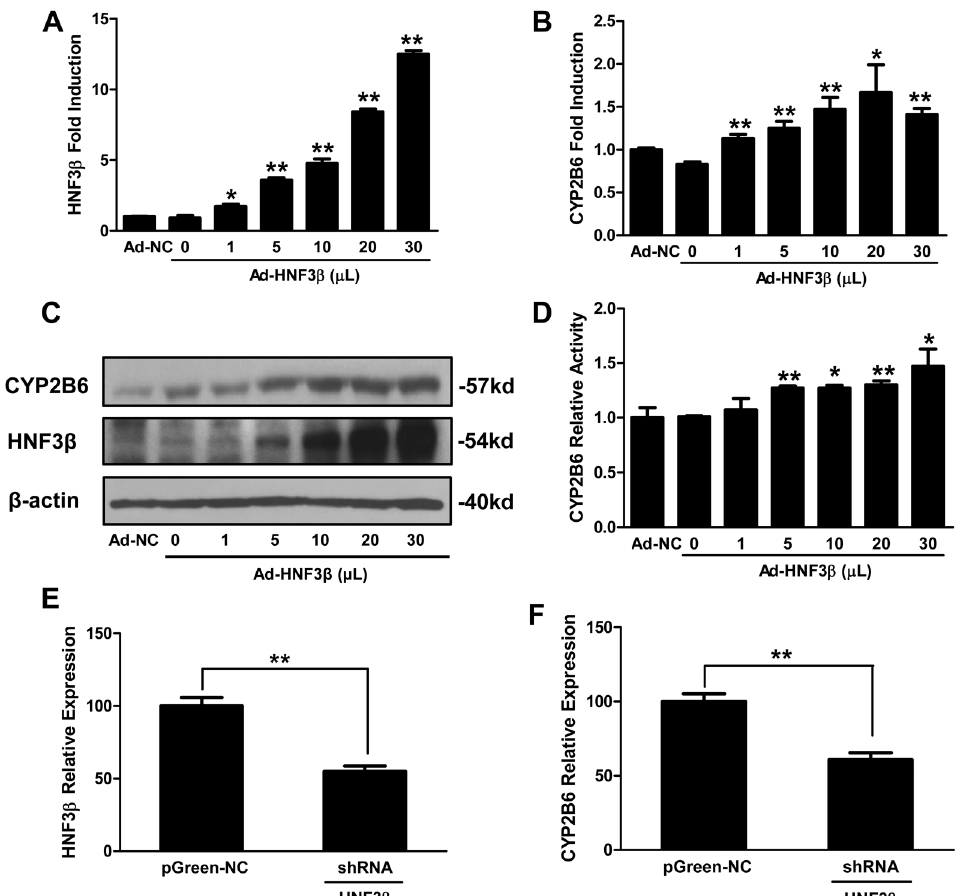
Fig 2. Effects of HNF3 β on the expression and activity of CYP2B6 in HepG2 cells. HepG2 cells were infected with Negative Control Adenovirus (Ad-NC) or various amounts of adenovirus expressing HNF3 β (Ad-HNF3 β ) for 48 h. Expression of HNF3 β mRNA (A), CYP2B6 mRNA (B), and their proteins (C) were measured using real-time PCR and Western blotting assays, respectively. CYP2B6 enzymatic activity (D) was detected using P450-Glo ™ CYP2B6 Assay kit (Promega). In separate experiments, HepG2 cells were infected with pGreen Negtive Control Lentivirus (pGreen-NC) or HNF3 β -RNAi lentivirus (HNF3 β - shRNA) for 96 h before measuring the mRNA expression of HNF3 β (E) and CYP2B6 (F) by real-time PCR. Results are expressed as the mean ± S.D. (n = 3). ( * P < 0 . 05 , ** P < 0 . 01